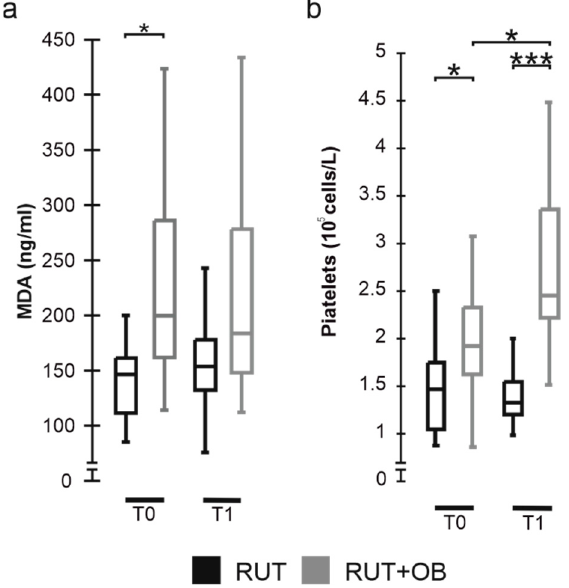
Figure 4. Distribution of MDA levels ( a ) and platelet counts ( b ) between groups at different time points. Data are represented as boxplots showing median and IQR (25–75%). *: p ≤ 0.05; *** p < 0.0001.